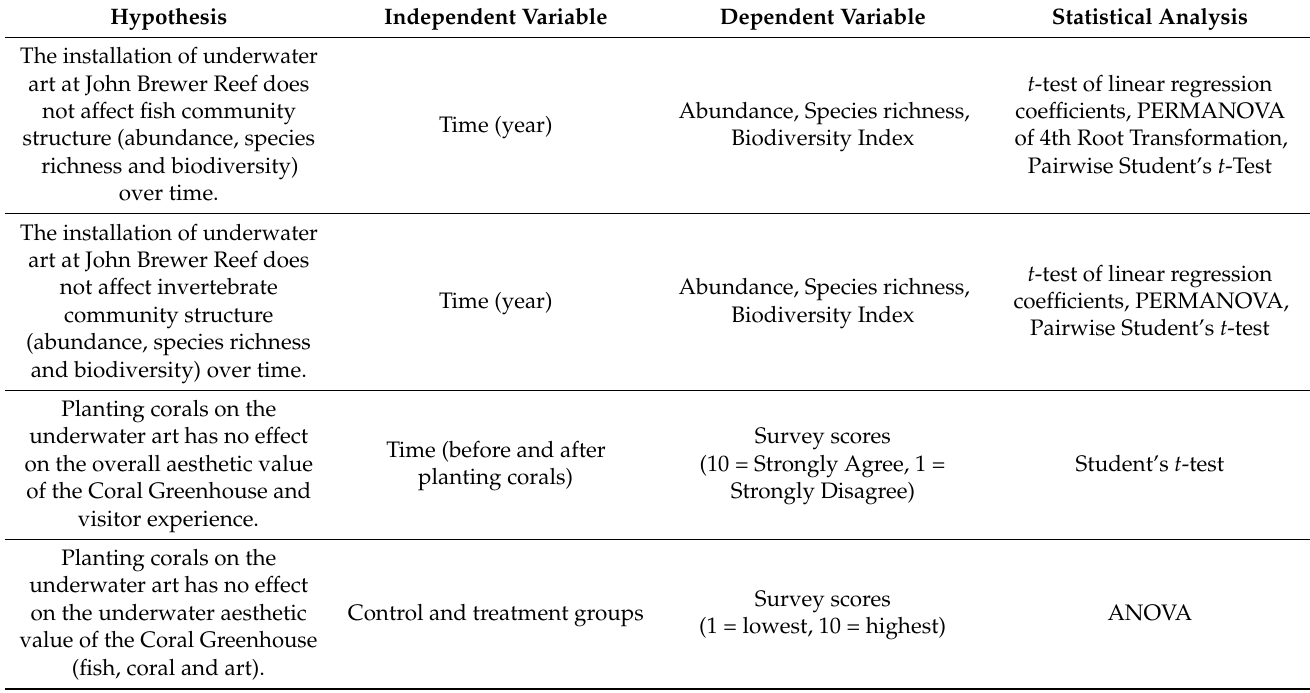
Table 1. Statistical analysis performed to compare different